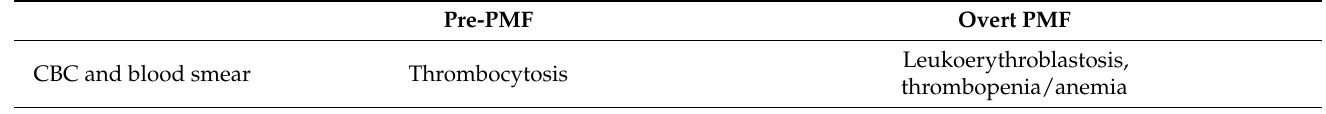
Figure 6. Morphological aspect of megakaryocytes in BM pre-PMF. ( a ) Atypical megakaryocytes with variable size (large to small) in pre-PMF: with hyperchromatic nuclei; ( b – d ) Enlarged megakaryocytes with variable lobulation; ( e , f ) Scattered small megakaryocytes with nude nuclei in platelet clusters. (Optical microscopy, May Grünwald Giemsa, × 100 magnification). Table 5. Cytomorphologic features for pre-PMF and PMF diagnosis. Pre-PMF Overt